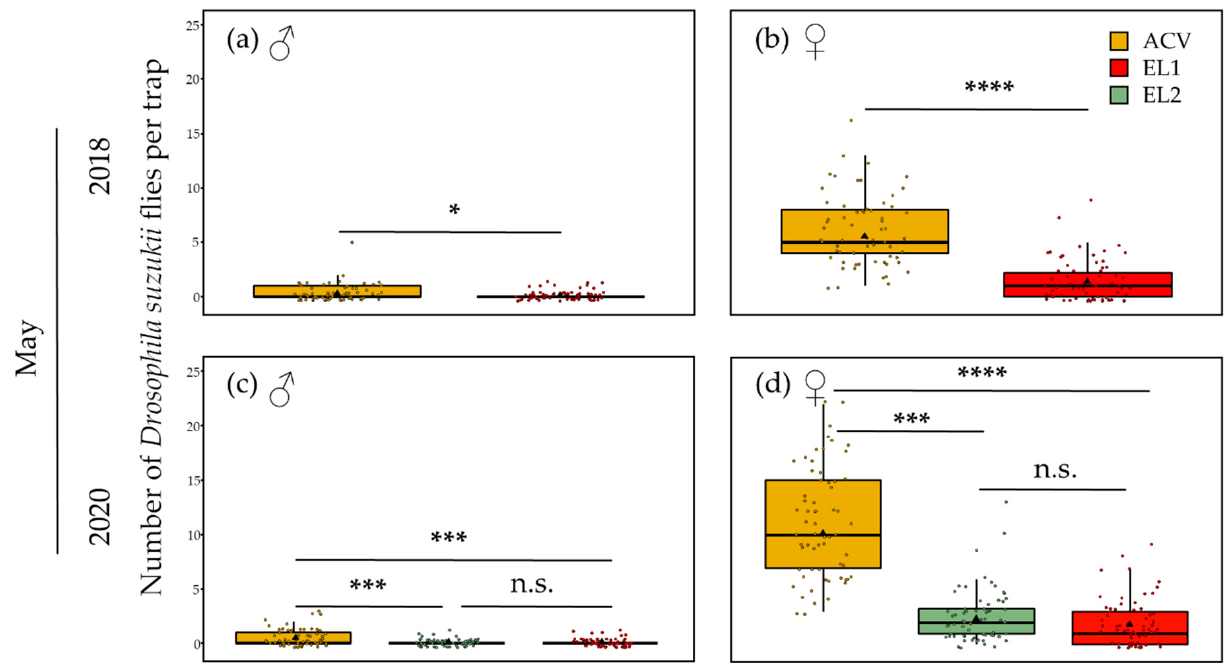
Figure 6. Number of D. suzukii flies per trap per sex and attractant in May. Jittered points and boxplots represent the 64 replicate traps and their distribution, respectively. Black triangles represent the estimated marginal mean number of D. suzukii flies per trap (GLMM). Lines connecting boxplots with asterisks above indicate the level of significance regarding the difference in the estimated marginal means of different attractants (GLMM, * p ≤ 0.05, ** p ≤ 0.01, *** p ≤ 0.001, **** p ≤ 0.0001, n.s.: not significant). ( a ) For the males in May 2018, regardless of the low proportion of overwintering males, significantly more flies were caught with ACV than with EL1. ( b ) For the females, the same is observed. ( c , d ) In 2020 for both males and females, ACV caught significantly more D. suzukii than both EL1 and EL2, with the latter two not significantly